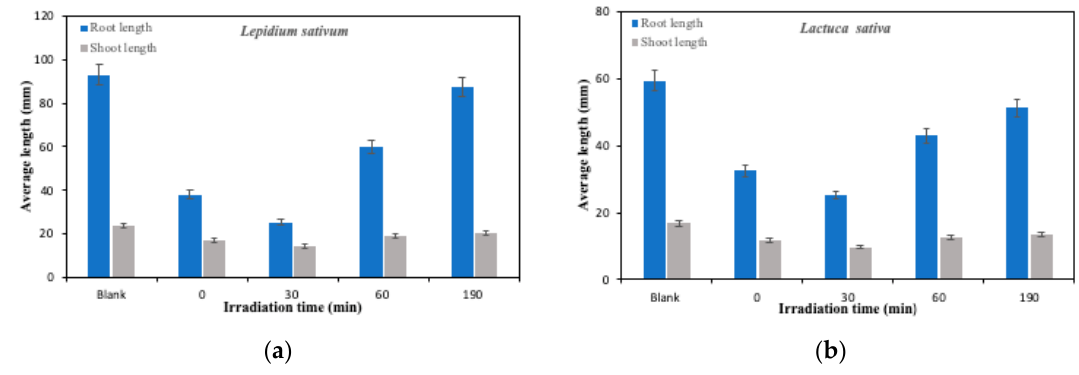
Figure 9. Average root and shoot length for Lepidium sativum ( a ) and Lactuca sativa ( b ), determined for blank, untreated, and photocatalytic treated solutions (30 mg/L of pollutant, 1 g/L of catalyst, 9.52 mW/cm 2 , room temperature).